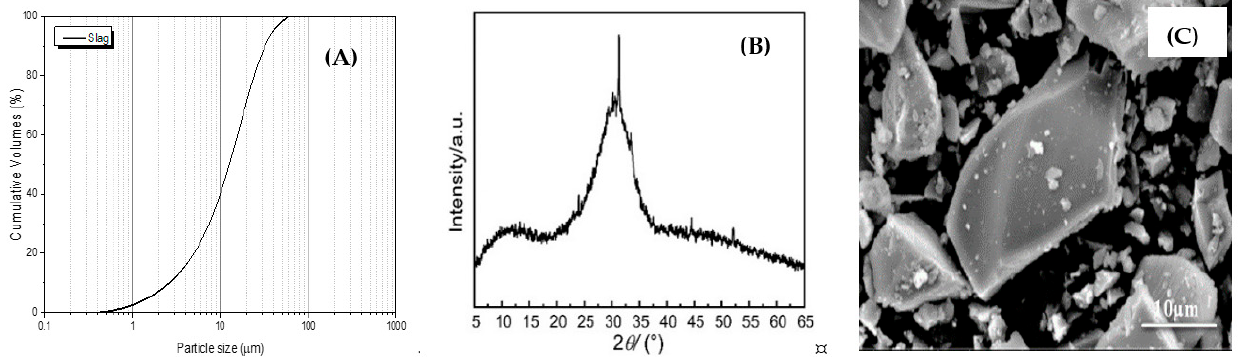
Figure 1. Physicochemical properties of slags: ( A ) particle size distribution, ( B ) XRD pattern, and ( C ) SEM